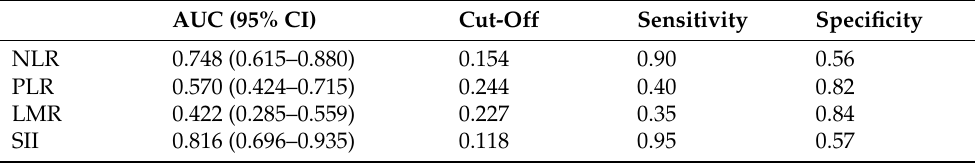
Table 5. ROC analysis.